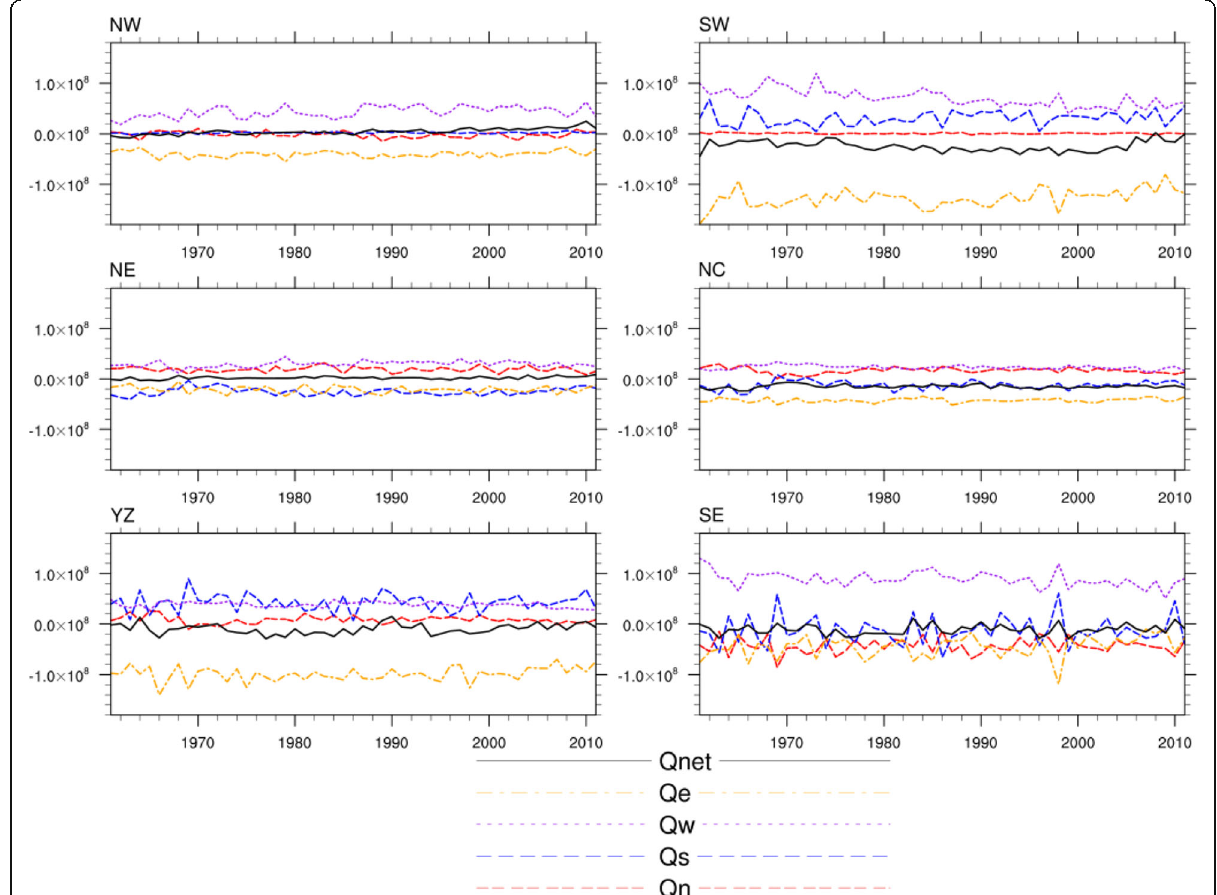
Fig. 6 Yearly variation of the water vapor budget via each regional boundary in winter from 1961 to